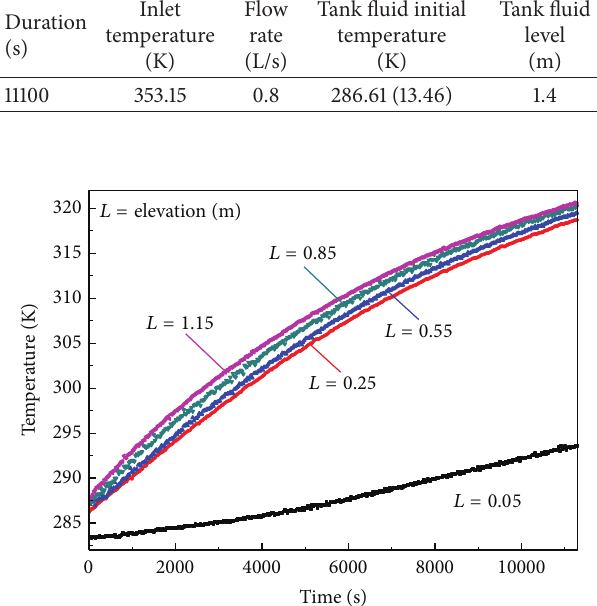
Figure 4: Tank fluid temperatures at different elevations as a function of time at position